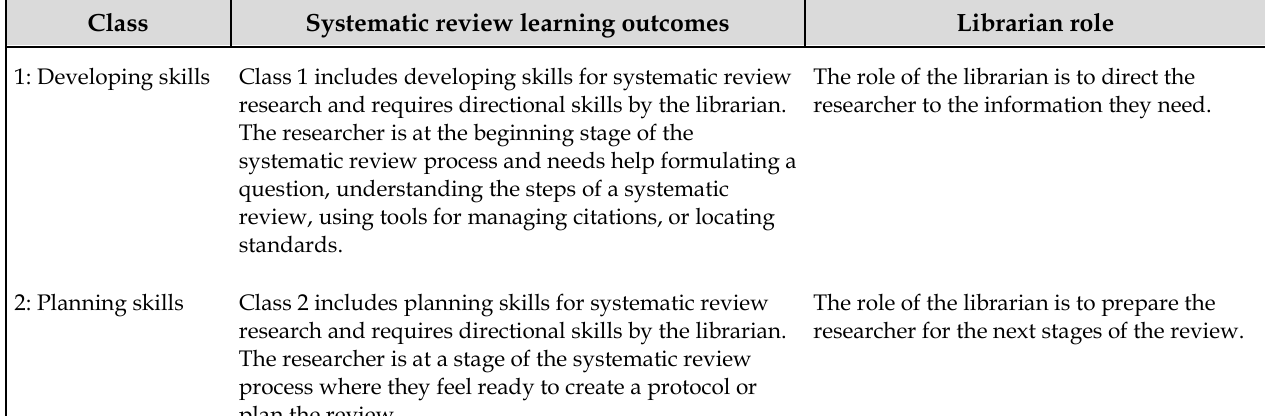
Table 1 Four classes of systematic review learning outcomes for researchers